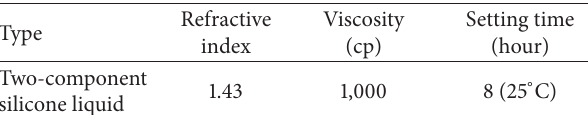
Table 2: Characteristics of silicone filler.